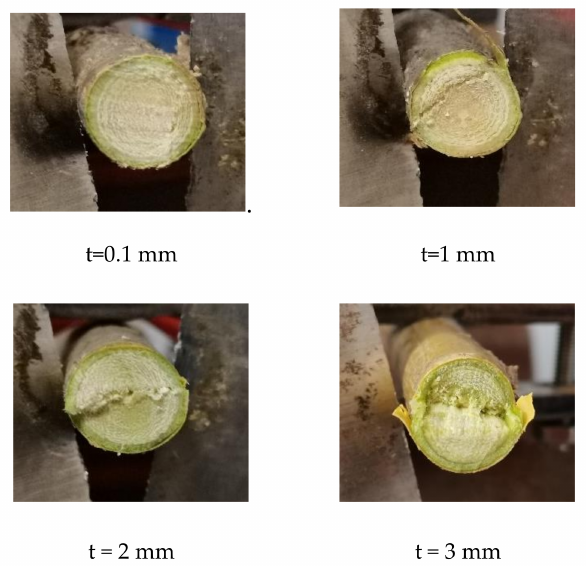
Figure 18. Cutting section with different cutting gaps during supported